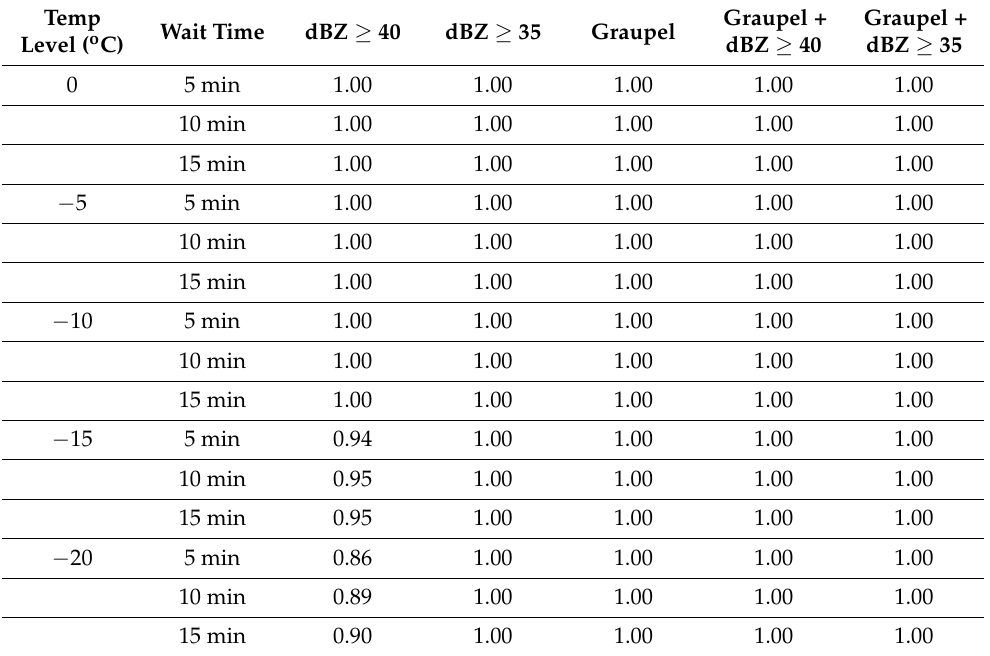
Table 2. Probability of Detection defined by the total number of hits divided by the total number of hits and misses: POD = total hits/(total hits + total